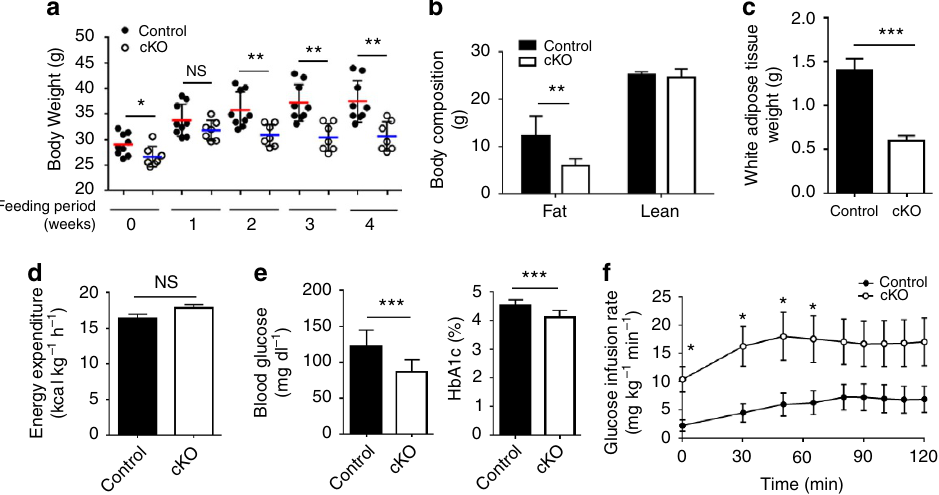
Figure 5 | Ant2 deletion in the liver mitigates obesity under a high fat diet. Control and Ant2 cKO mice at the age of 28 weeks were subjected to a high fat diet (60%) for 4 weeks. ( a ) Body weight changes under the high fat diet regimen ( n 4 9, * P o 0.05, ** P o 0.01 by t -test, error bars ¼ s.d.). ( b ) Fat and lean mass assessed by TD-NMR analysis ( n ¼ 10, ** P o 0.01 by t -test, error bars ¼ s.d.). ( c ) Weight of white adipose tissue ( n ¼ 10, *** P o 0.001 by t -test, error bars ¼ s.d.). ( d ) Energy expenditure assessed by a comprehensive laboratory animal monitoring system (CLAMS). ( e ) Plasma levels of fasting glucose and HbA1c ( n ¼ 10, *** P o 0.001 by t -test, error bars ¼ s.d.). ( f ) Glucose infusion rate during hyperinsulinemic-euglycemic clamp ( n ¼ 5, * P o 0.05 by t -test, error bars ¼